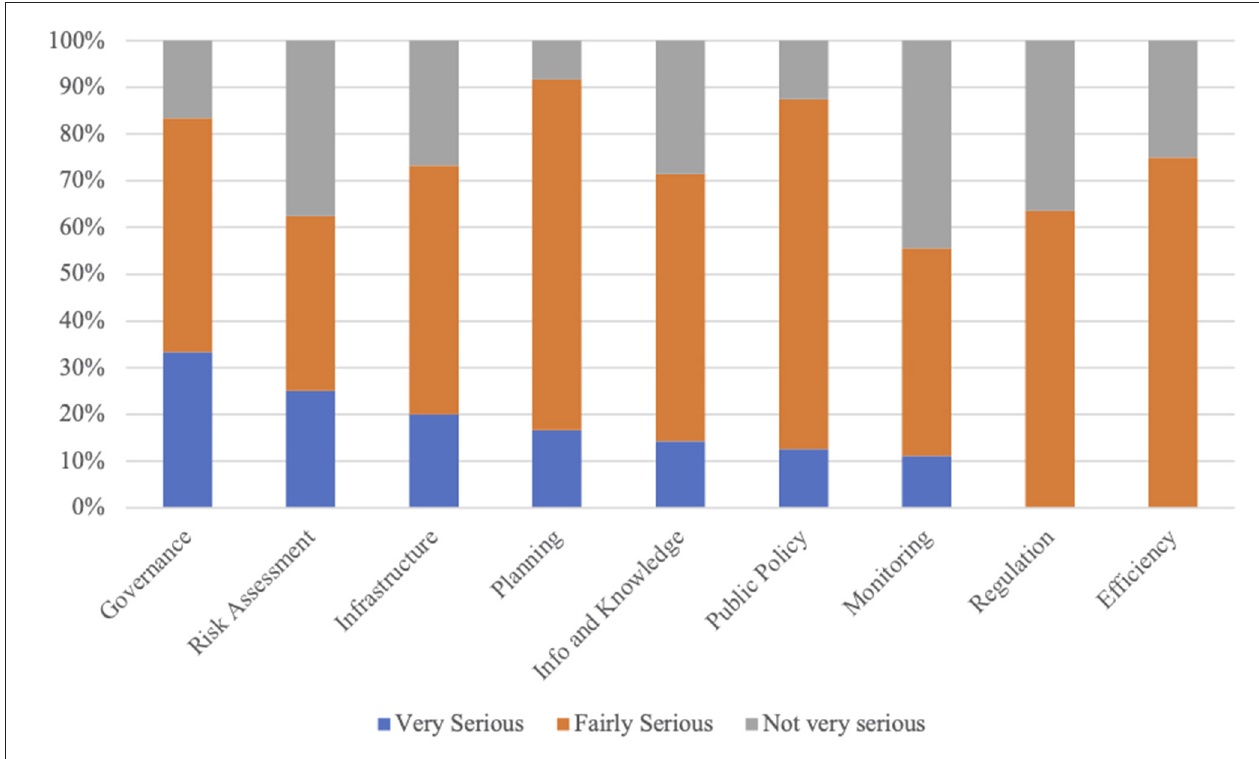
FIGURE 6 | Perceptions of issues involving integrated areas of water and